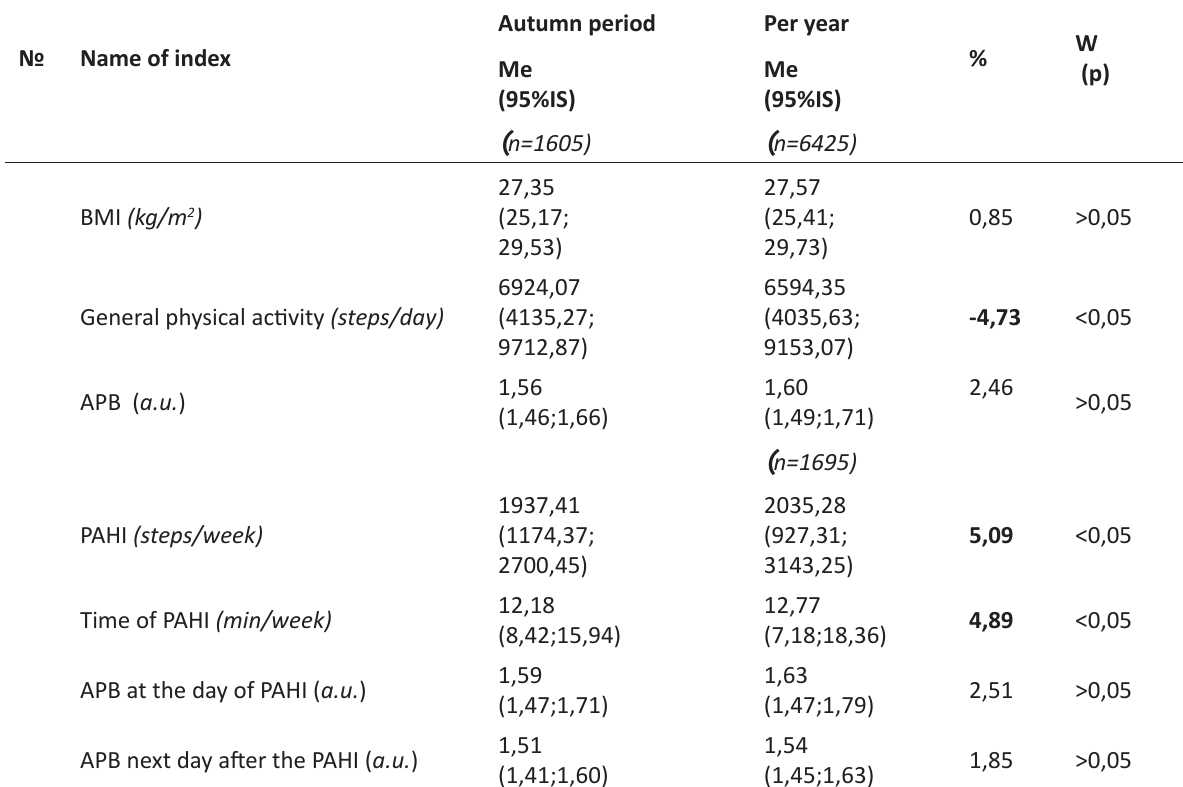
Table 4. C omparison of indicators of physical condition and physical activity of men in autumn period